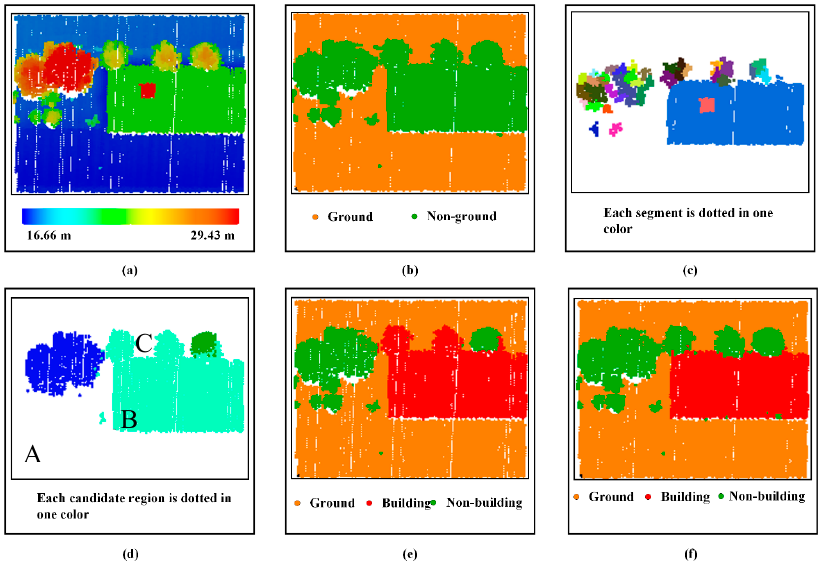
Figure 6. An example for building point detection. ( a ) Raw point cloud. There are a building and several trees, and three trees are near to the building; ( b ) Filtering result. Ground and non-ground points are separated; ( c ) Some non-ground segments; ( d ) Generated building candidate regions by grouping non-ground segments; ( e ) Result of TRG classification. Only one candidate region is labeled as a building; ( f ) Non-building points near the building are removed, and the remained points are classified as building